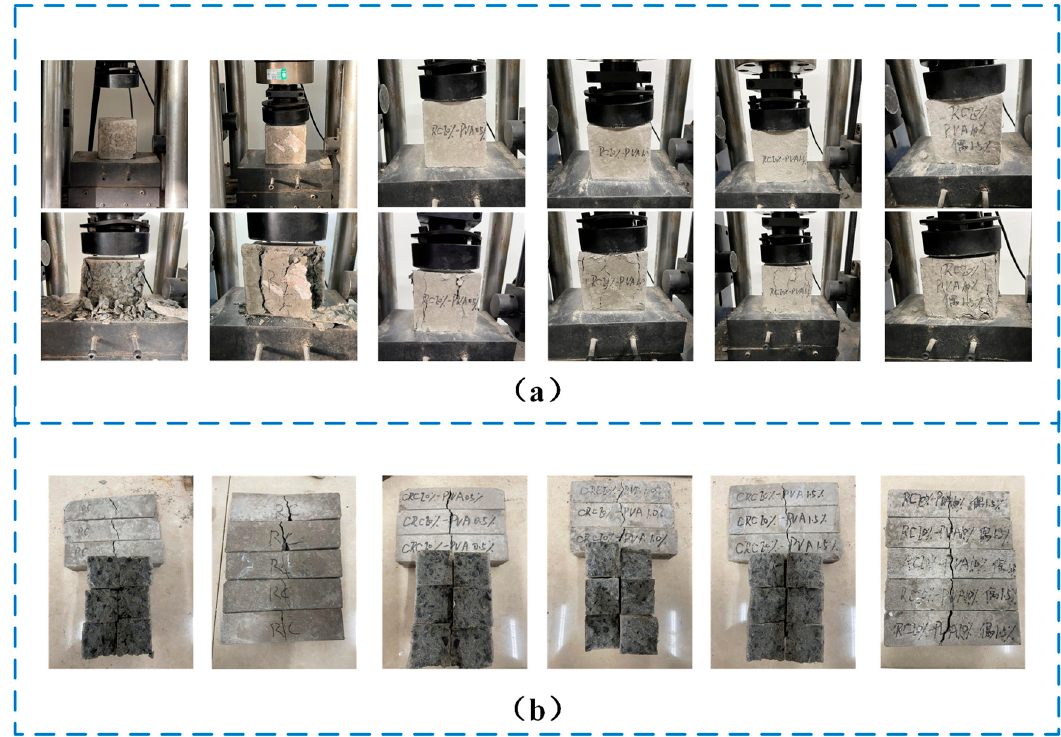
Figure 3. Compressive and flexural test process diagram of specimens under different dosages: ( a ) Compressive test diagram of PVA-Rubber/concrete with different dosages; ( b ) Flexural test diagram of PVA-Rubber/concrete with different dosages.